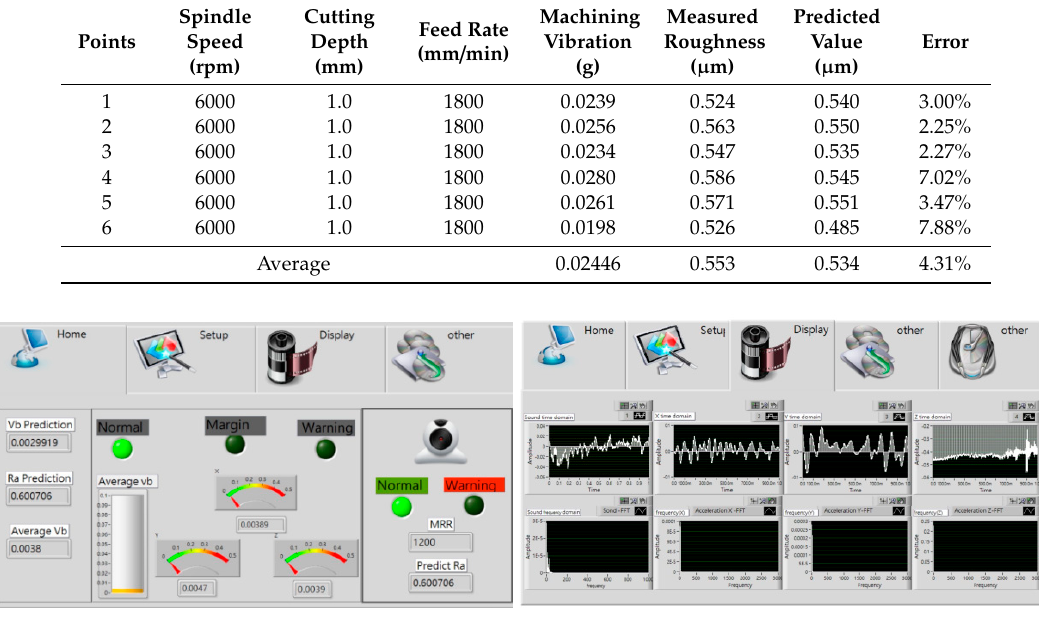
Figure 16. Monitoring system for machining vibration and prediction of surface roughness.